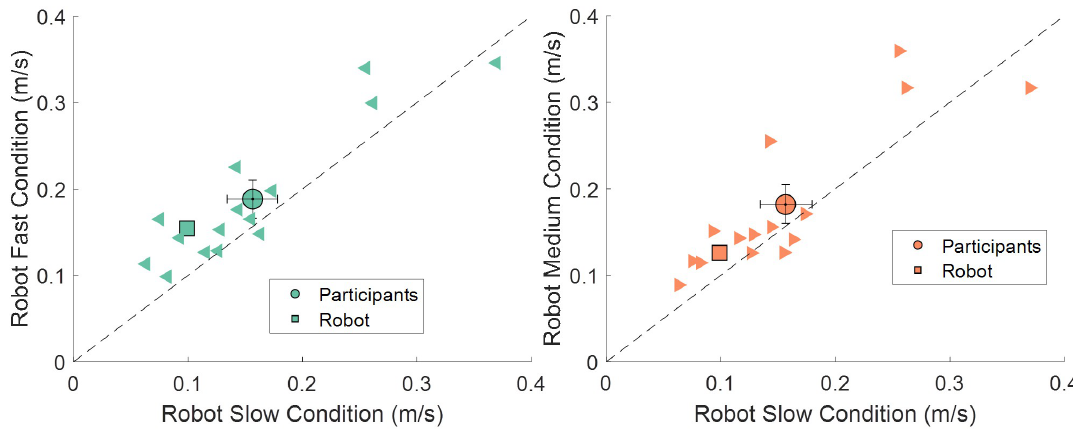
Figure 5: Individual speed of subjects in the “Robot Fast” (left) and ”Robot Mid” conditions (right), in relation to their speed in the “Robot Slow” condition in the “One Box” sessions. The bigger circles with error bars represent the sample mean and standard error. If a subject maintained the exact same speed, for example, in the “Robot Fast” and ”Robot Slow” condition, the corresponding marker would be on the dashed line. Similar results derive from the analysis of the “Two Boxes” condition (Italy).